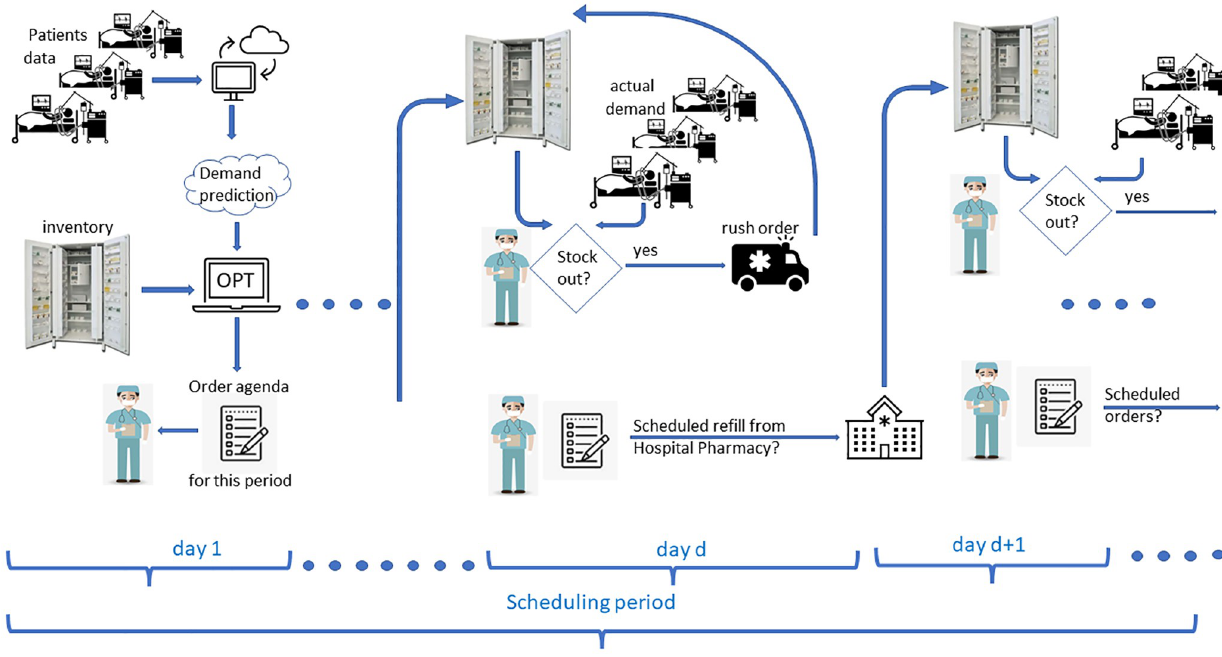
Fig 15. Main decision flows in the deployment of the tool. Prediction and optimization modules are launched at the beginning of each scheduling period.